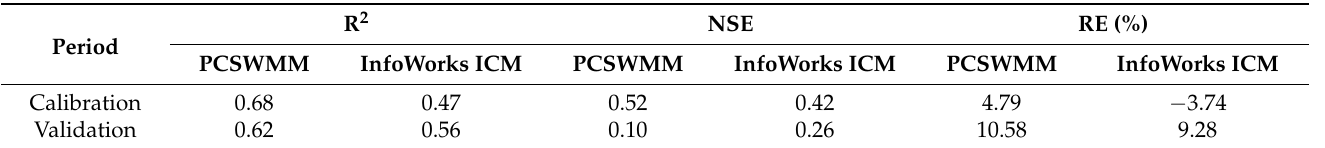
Table 3. Model performance for the calibration and validation periods.